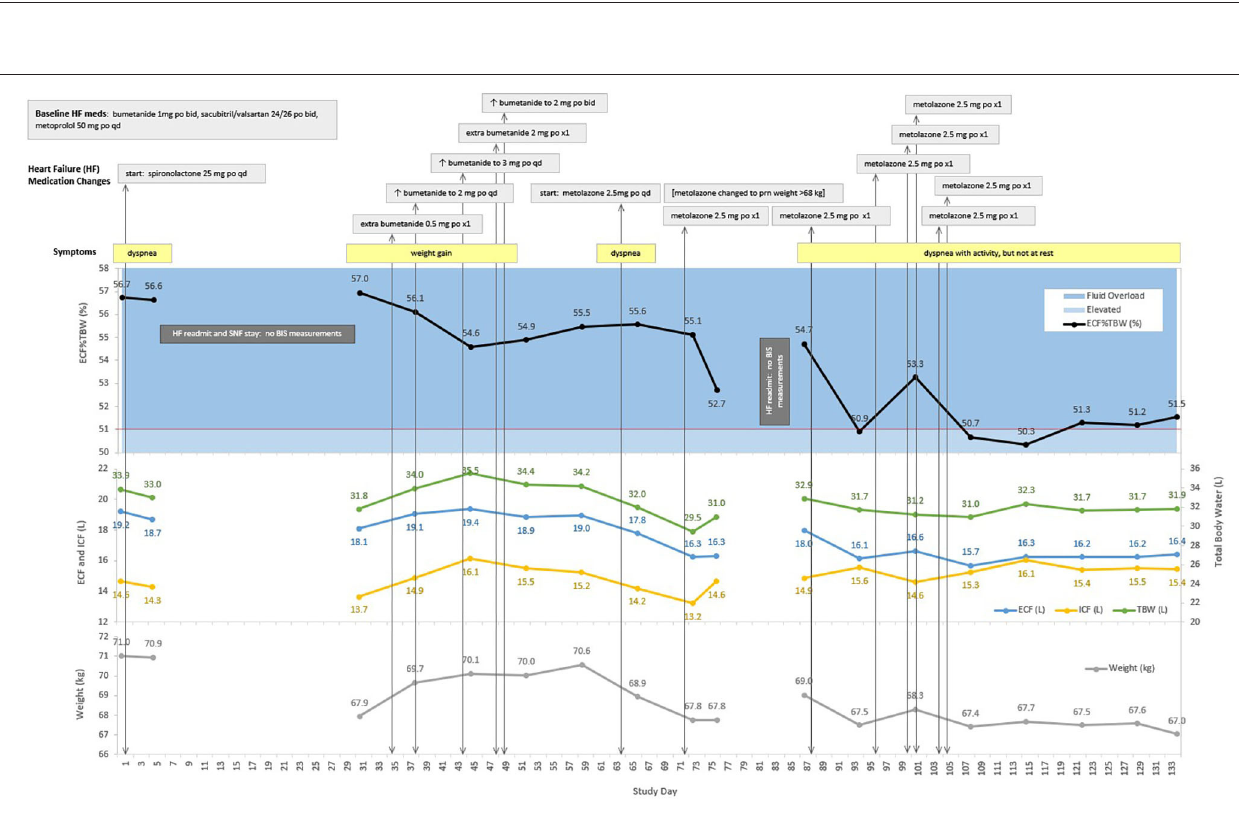
Frontiers in Cardiovascular Medicine |